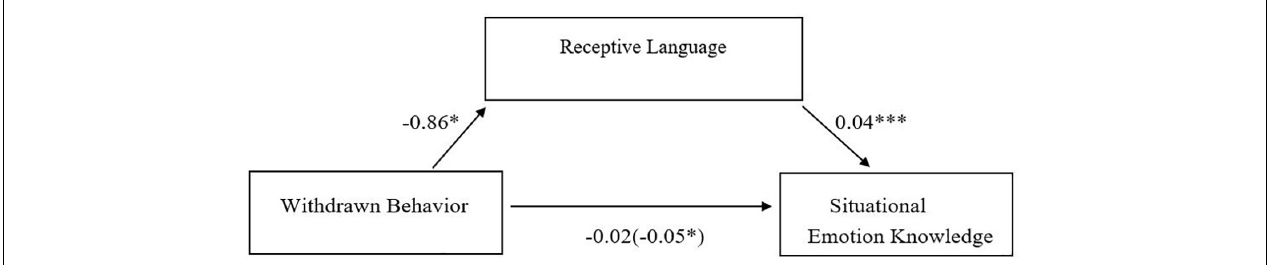
FIGURE 2 | Simple mediation model for the relationship between child withdrawn behavior and situational emotion knowledge, as mediated by receptive language. ∗ p < 0.05, ∗∗∗ p < 0.001.